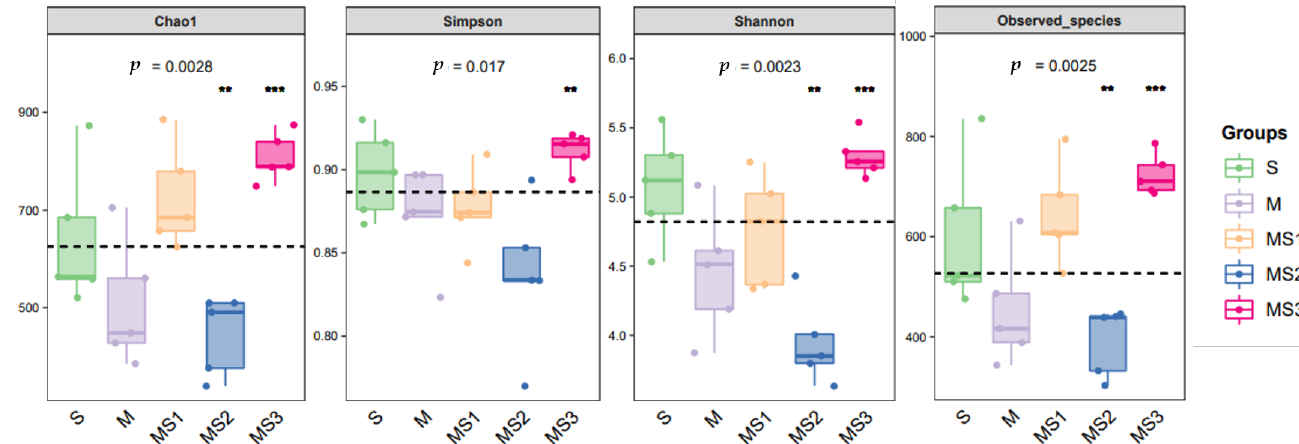
Figure 2. Boxplots of the Chao1, Shannon, and observed species indexes after silage fermentation of the different treatments. The numbers under the Alpha-diversity Index label are the p -values of the Kruskal – Wallis test. Asterisks: ** denotes significant difference ( p < 0.01); *** denotes significant difference ( p < 0.001). S: monoculture of soybean; M: monoculture of maize; MS1, MS2, and